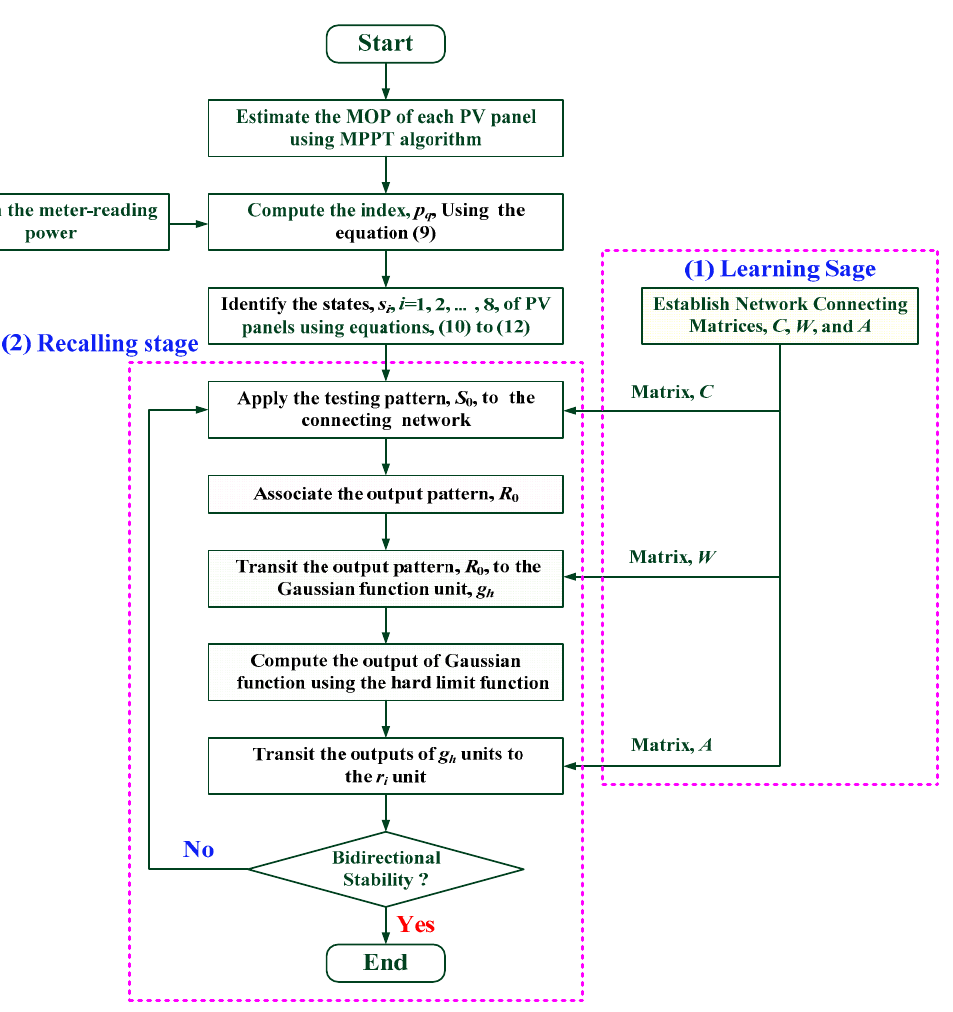
Figure 5. The flow chart of fault location and BHAM algorithm.